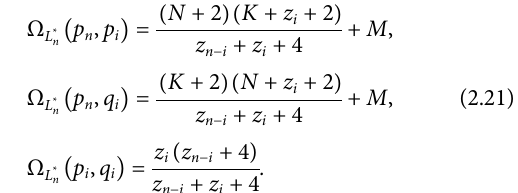
FIGURE 3 | L * n and circuit reduction to fi nd Ω L *